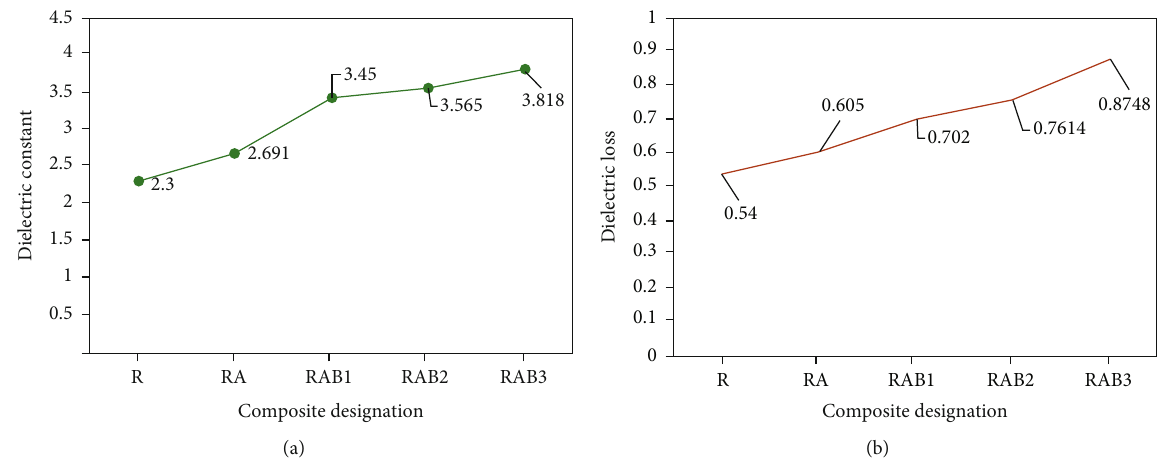
Figure 9: (a) Dielectric constant and (b) dielectric loss for di ff erent composite